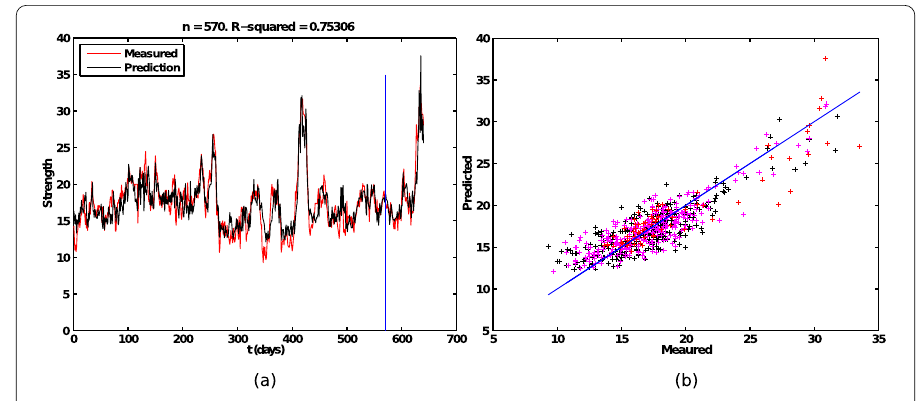
Figure 1 Model prediction. (a) Comparison of measured alumina strength exiting calcination (red line) with stepwise regression strength model (black line). The data to the left of the vertical blue line is used to construct the model. The curves to right of the blue line show the predictive power of the model. (b) Plot of measured strength against stepwise regression model, where the black, magenta and red points correspond to the training set, testing set and predicted values, respectively. Strength values are not included in graphs due to confidentiality